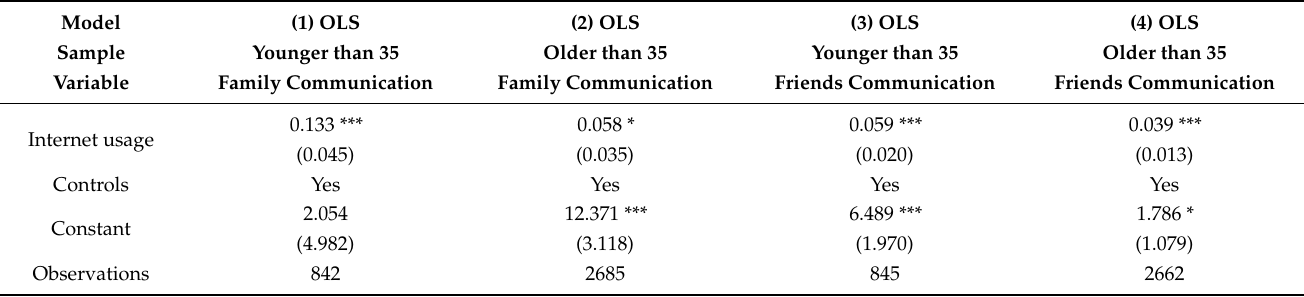
Table 12. Heterogeneity analysis, in terms of